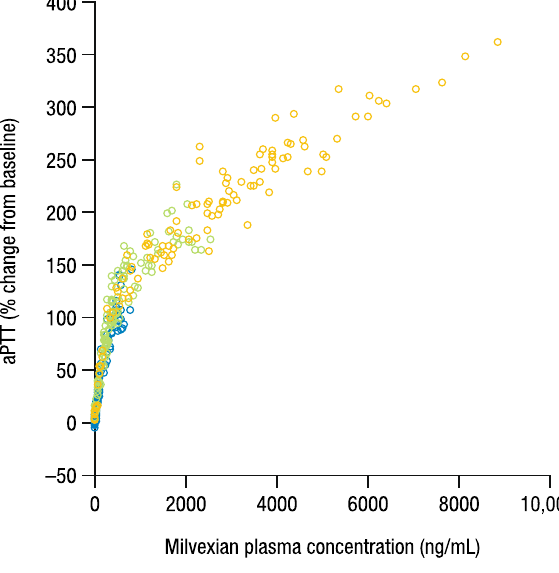
Figure 3. Percent change from baseline in aPTT versus milvexian plasma concentration. aPTT, activated partial thromboplastin time.